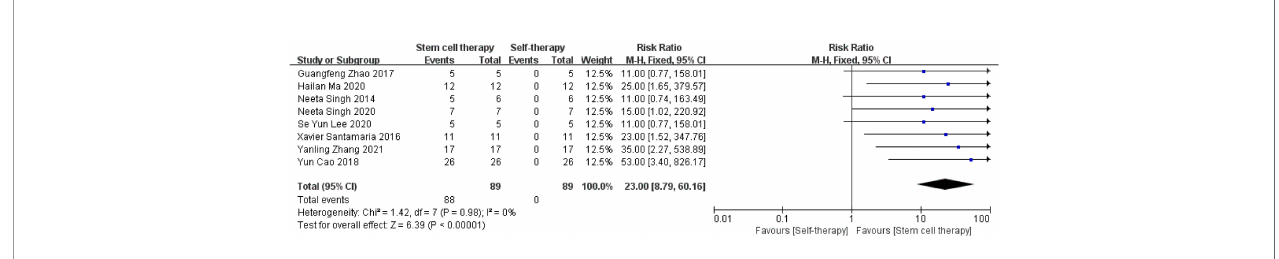
FIGURE 3 | Menstruation